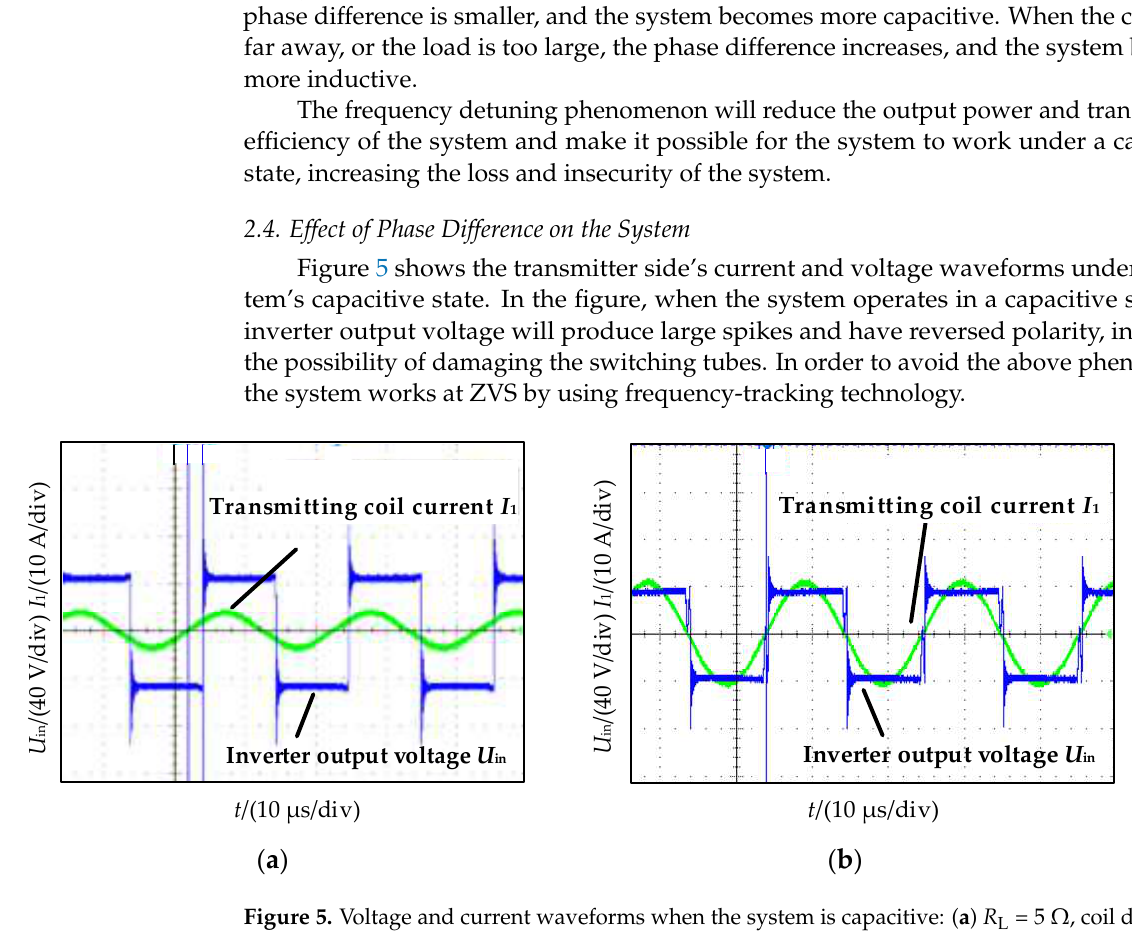
×10 4 Figure 4. Relation curve of system frequency with transmission efficiency and output power when there is no frequency splitting.